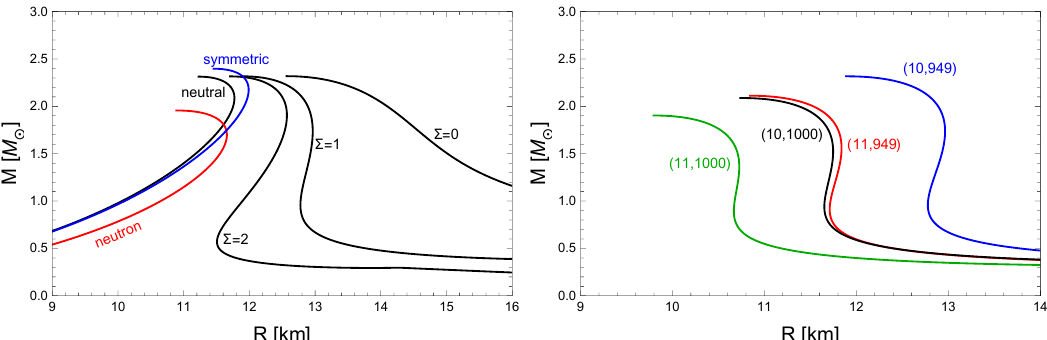
Figure 2: Left panel: Black curves show the effect of the crust, from no crust at all (left) through crust with Coulomb and surface effects (middle, surface tension as la- beled, in units of MeV / fm 2 ) to crust without energy cost (right). For comparison, also the curves for symmetric nuclear matter and pure neutron matter are shown (blue = 949. Right panel: Mass- and red, both without crust). In this panel, λ = 10, M KK radius curves including the crust with Σ = 1MeV / fm 2 for different model parameters λ and M (in MeV), as labeled. All curves end at the maximal mass, beyond which KK the stars are unstable with respect to radial